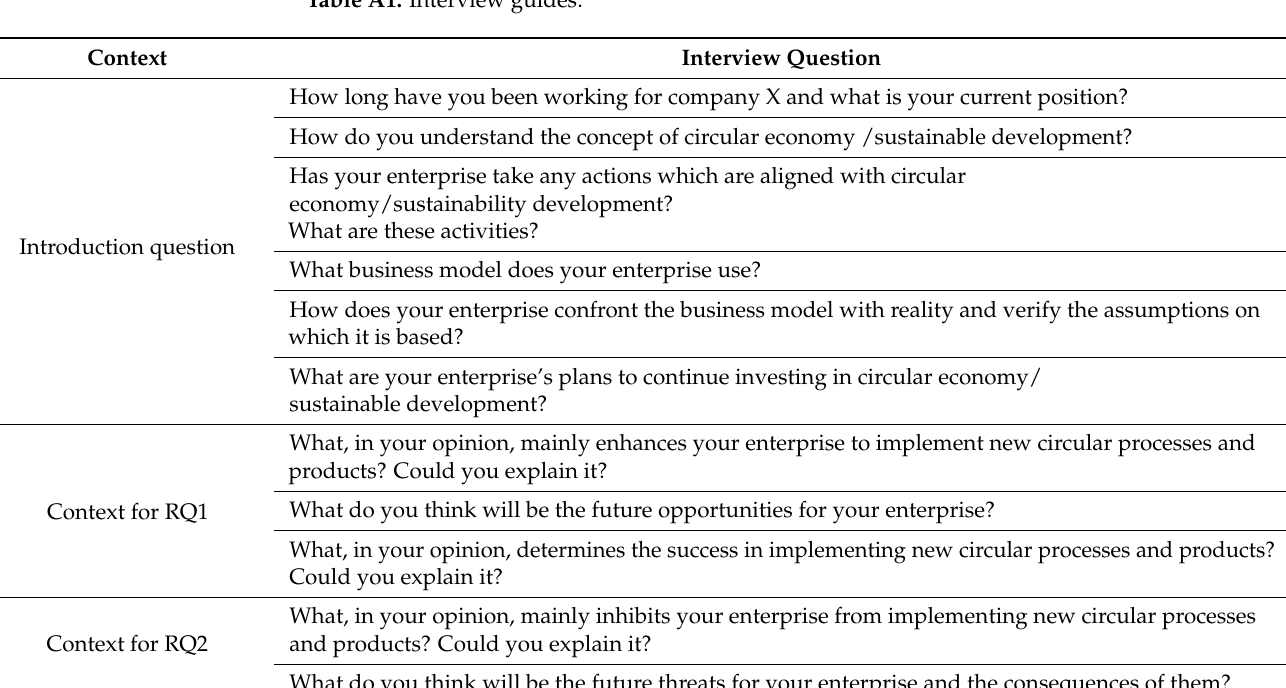
Table A1. Interview guides.